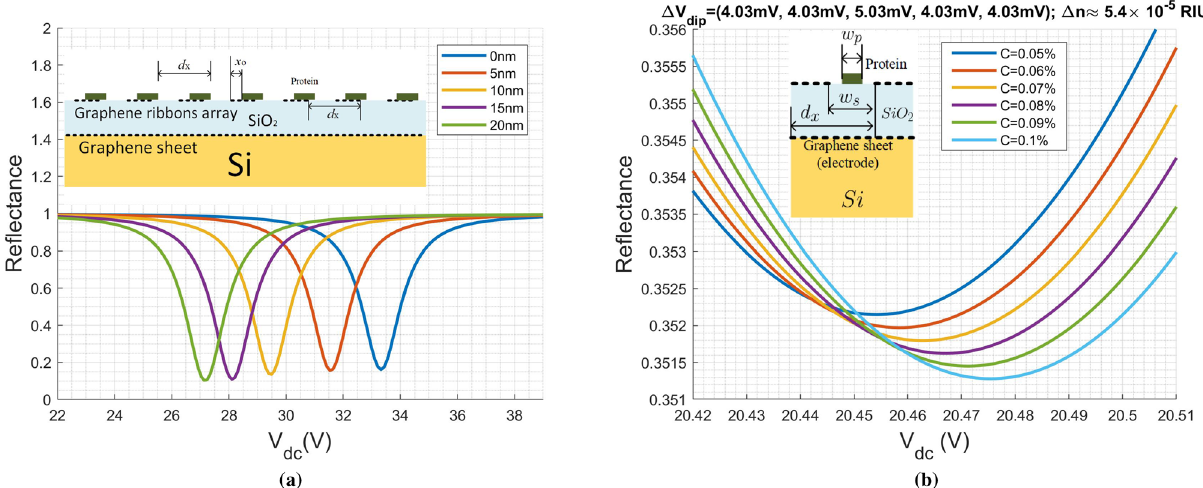
Figure 4. ( a ) Reflectance versus gate voltage for various (lateral) shift position ( x o ) of the sensing targets, each with dimensions of 20nm × 8 nm , modeled by a periodic dielectric layer with period d x . ( b ) Reflectivity again applied gate voltage for various surface percentage coverage (or concentration: C